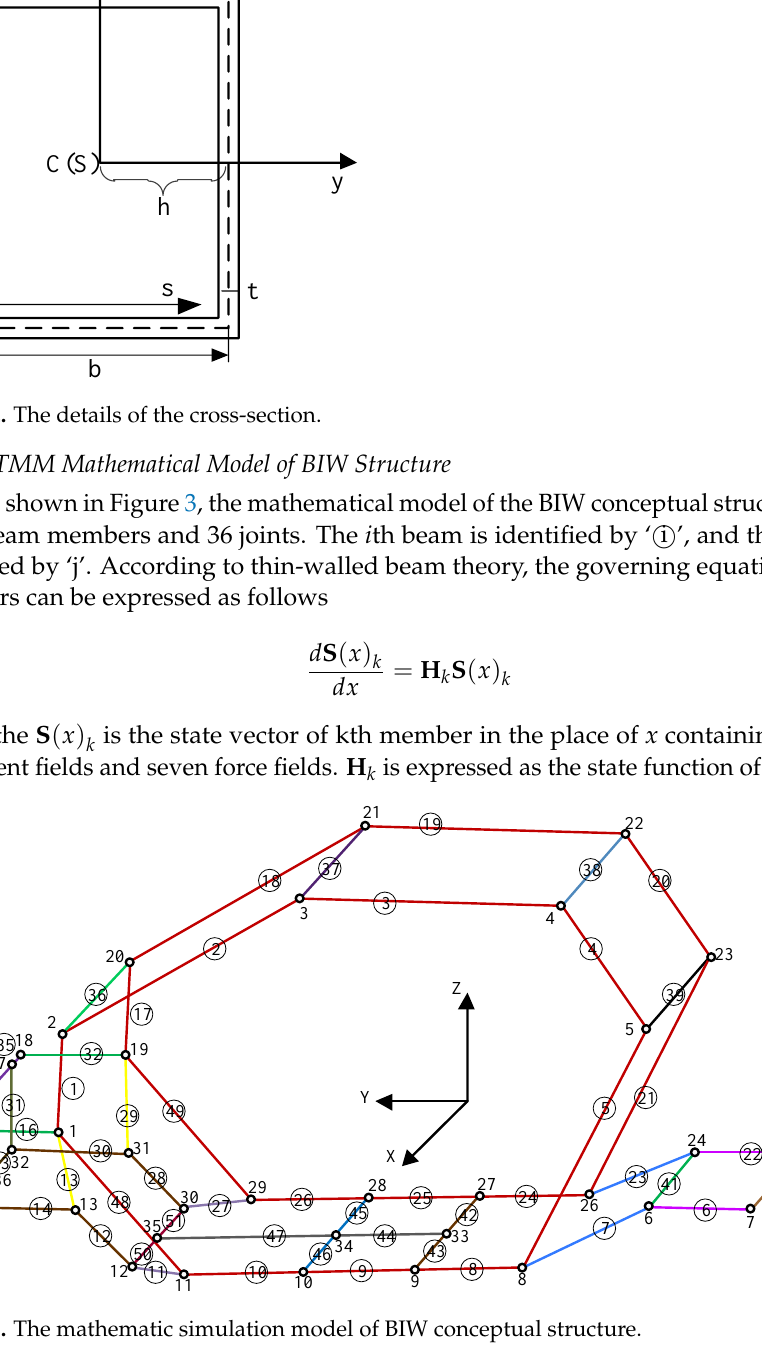
Figure 3. The mathematic simulation model of BIW conceptual structure.